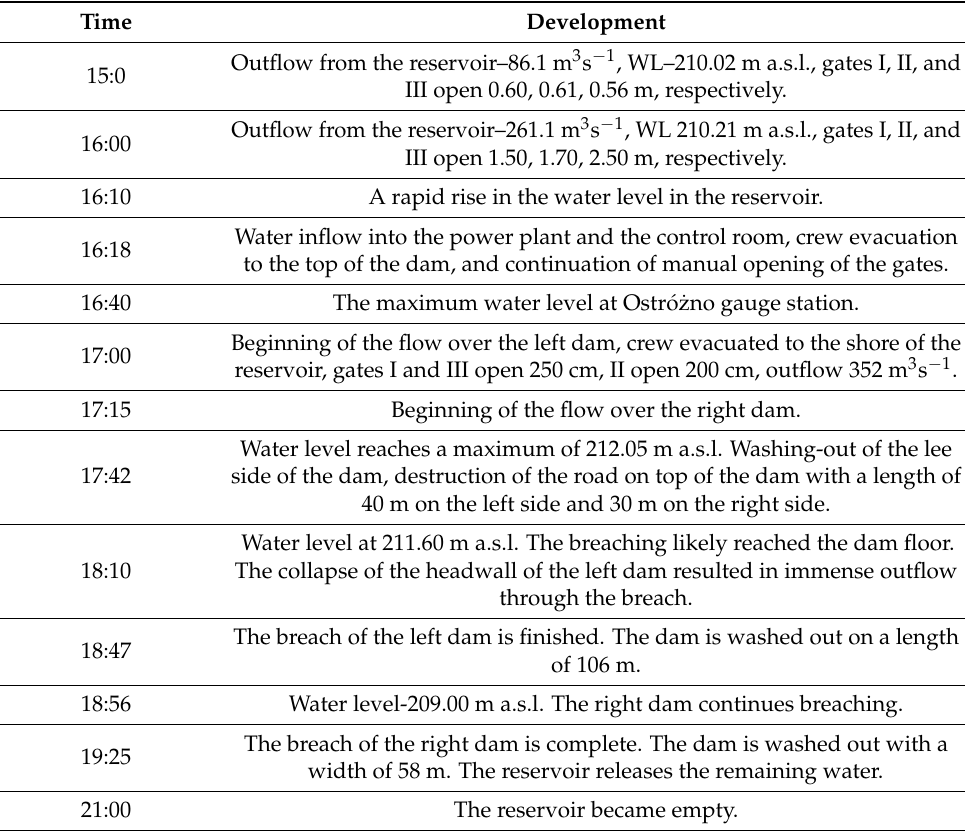
Figure 9. The final breach of the dam-an upstream view on 12 August 2010. Table 1. The development of the failure of the Nied ó w dam on 7 August